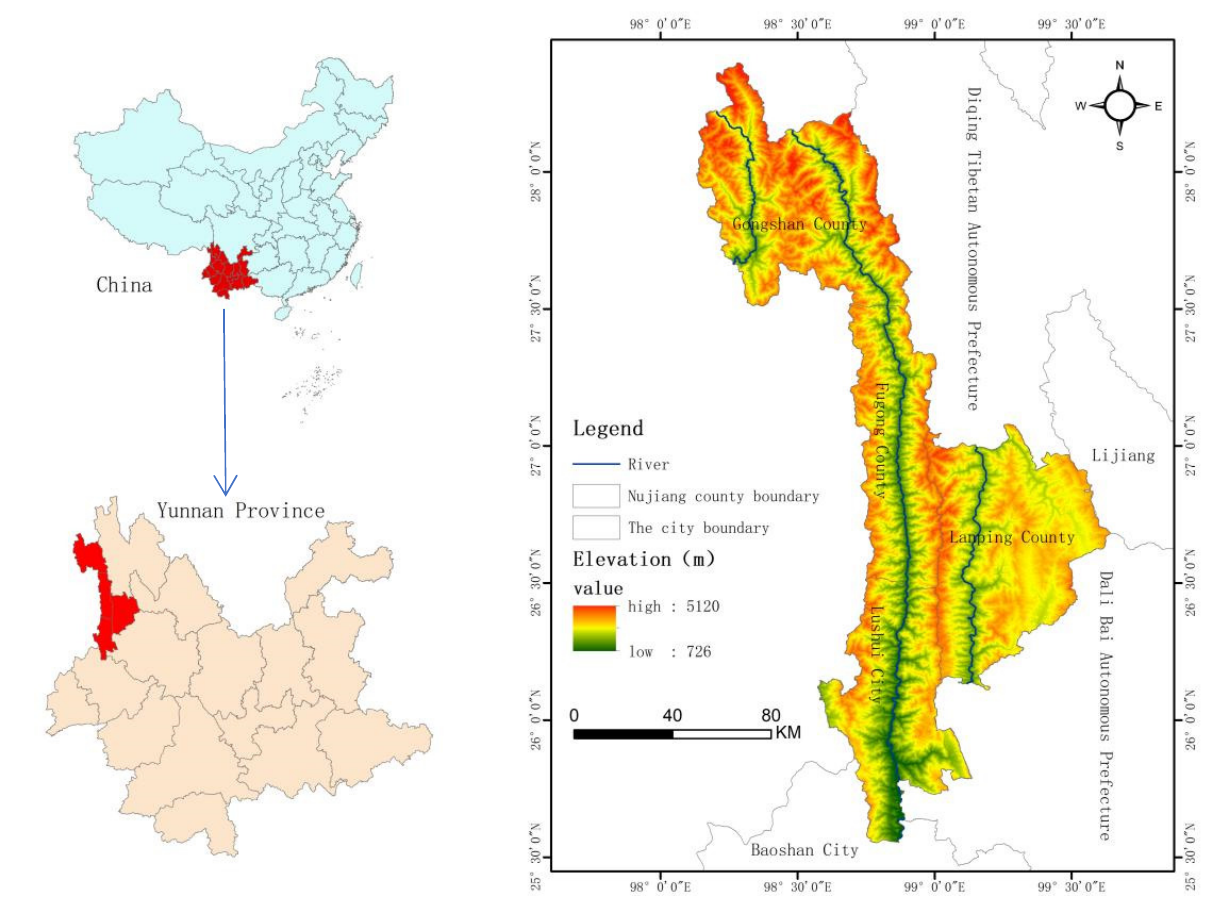
Figure 1. Location map of the study area.